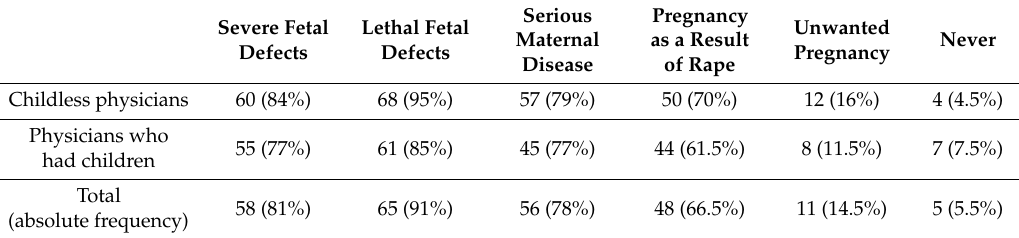
Table 3. Attitude towards pregnancy termination depending on having children.